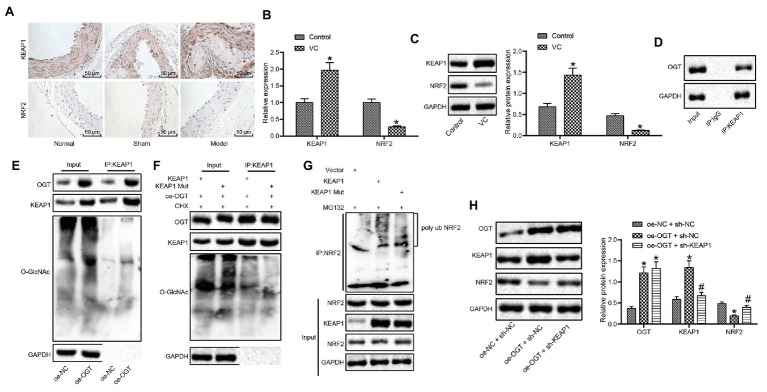
OGT overexpression accelerates kelch like ECH associated protein 1 (KEAP1) glycosylation leading to degradation of nuclear factor erythroid 2-related factor 2 (NRF2). (A) Immunohistochemical detection of KEAP1 and NRF2 expression patterns in rat models. (B) RT-qPCR detection of mRNA expression patterns of KEAP1 and NRF2 in cell models. (C) Western blot assay of protein levels of KEAP1 and NRF2 normalized to GAPDH in cell models. (D) Co-immunoprecipitation (Co-IP) assay showing the interaction between OGT and KEAP1. (E) IP and western blot assay of total protein and glycosylation of KEAP1 normalized to GAPDH in response to OGT overexpression. (F) IP and western blot assays of glycosylation of KEAP1 normalized to GAPDH in response to KEAP1 mutant (Mut). (G) IP and western blot assays of NRF2 ubiquitination extent normalized to GAPDH in response to KEAP1 Mut. (H) Western blot assay of protein levels of OGT, KEAP1, and NRF2 normalized to GAPDH in response to OGT overexpression and KEAP1 knockdown. *p < 0.05 vs. sham-operated rats, control cells, cells transduced with oe-NC, cells transduced with sh-NC, or cells transduced with oe-NC + sh-NC. #p < 0.05 vs. cells transduced with oe-OGT + sh-NC (n = 8 rats in normal group, sham group, and model group, and in vitro experiments were repeated three times independently in other groups).